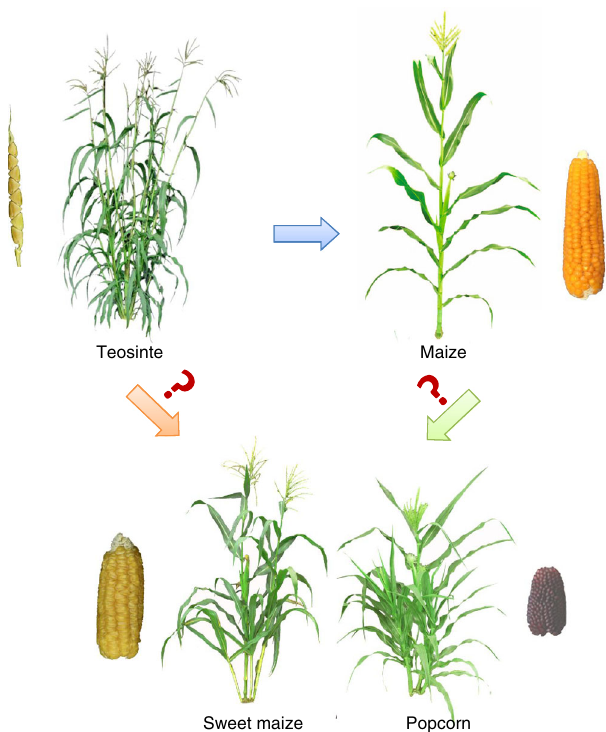
Fig. 1 Sweet maize and popcorn retained a tillering habit. Maize wild progenitor, teosinte (left), has multiple tillers and two-rowed ears, while domesticated maize (right) generally has a single strong stalk bearing a large ear. However, some maize types, including sweet corn (left) and popcorn (right), retain a tillering habit like that of teosinte. How and why sweet corn and popcorn retained this tillering habit remain